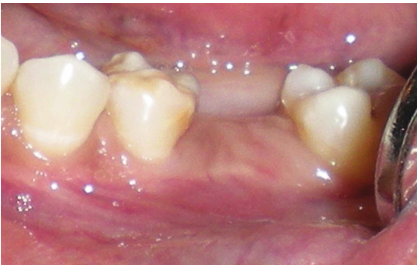
Figure 3: Crestal incision made along the crest of the ridge.